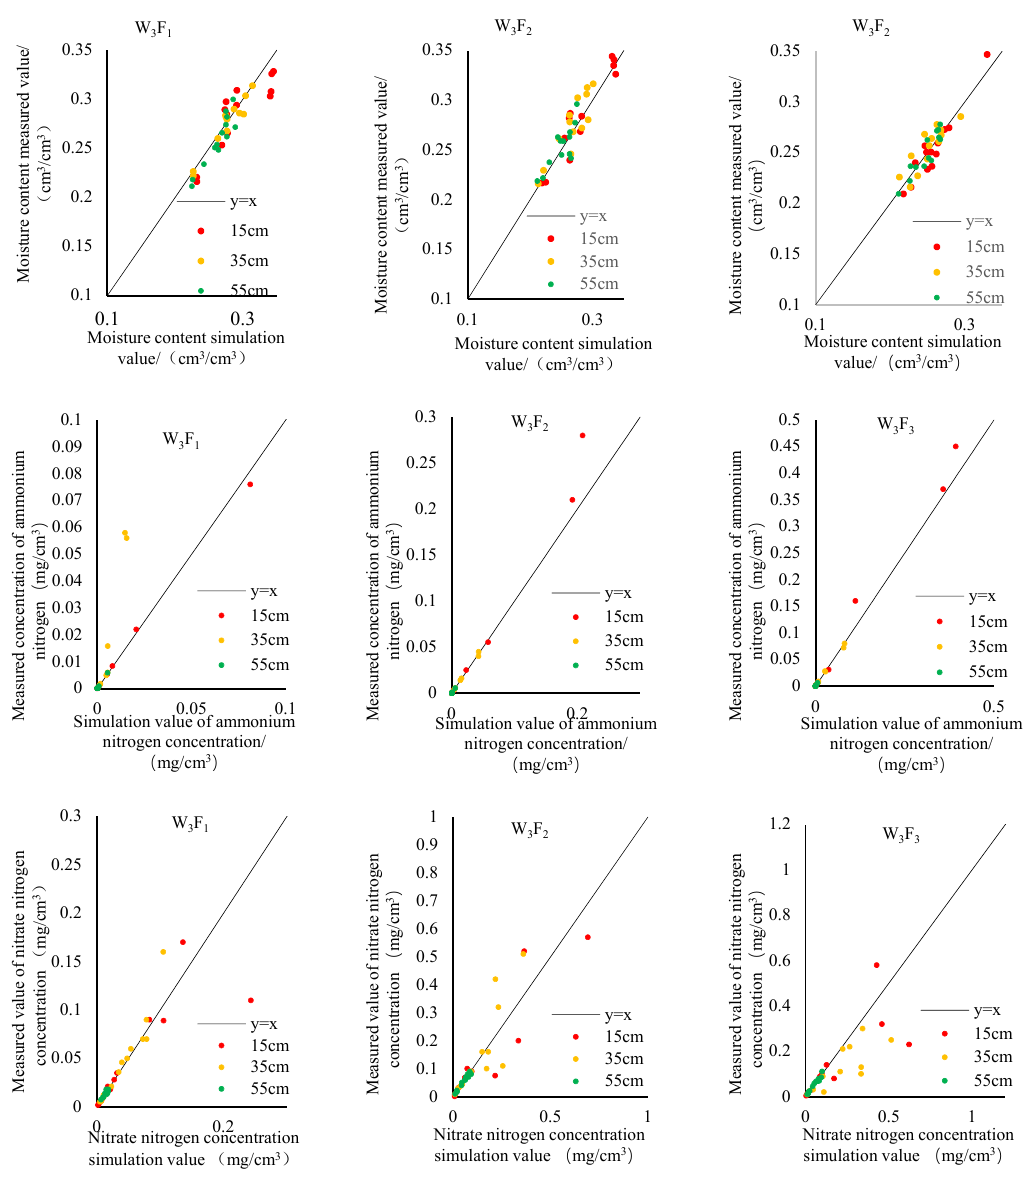
Figure 5. Comparison between simulated and measured values of horizontal water content, ammo- nium nitrogen, and nitrate nitrogen in